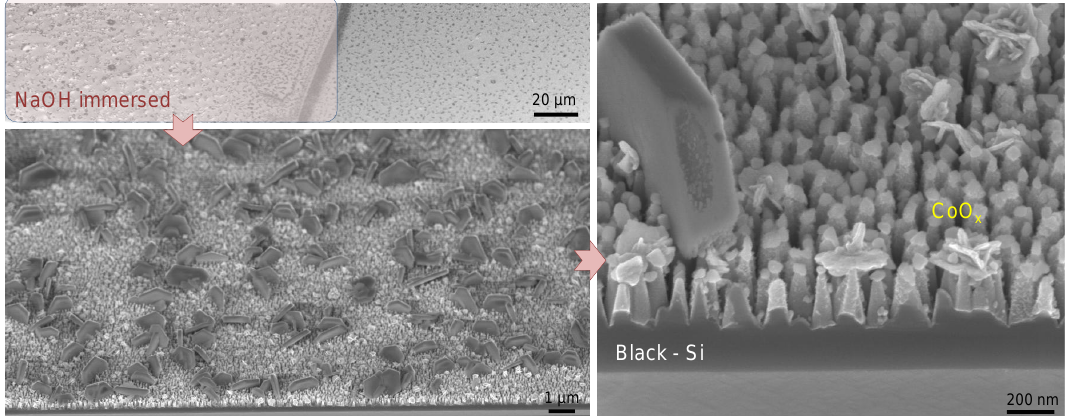
Figure 7. Potentiodynamic ( a ) and potentiostatic ( b ) scan at 1.23 V vs. RHE for the b-Si photoanodes fabricated for 20 and 40 min and coated with 10 nm TiO 2 with addition of 150 nm CoO x cocatalyst layer in NaOH electrolyte under chopped light illumination. The potential scan speed was 10 mV/s and light ON-OFF chopping with 8 s period in (a). ∼ ∼